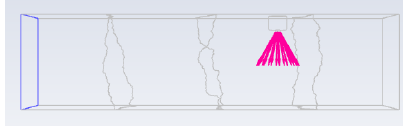
Fig. 4. Geometry of computational domain